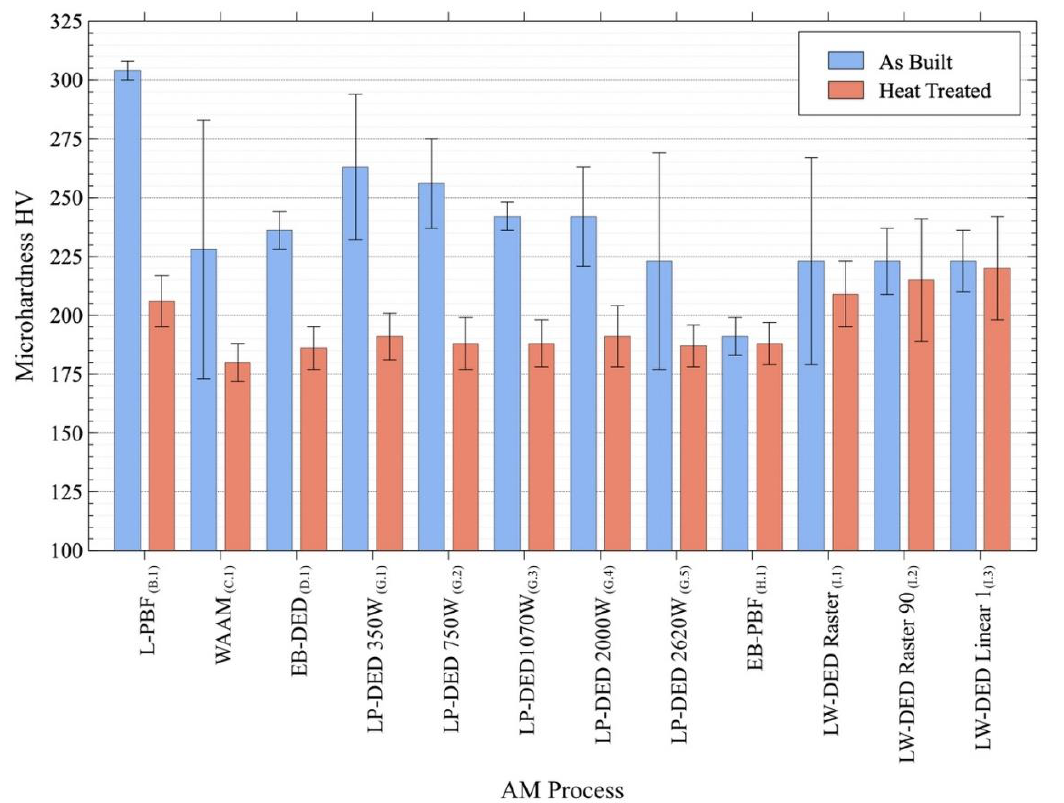
Figure 11. Comparison of microhardness in the as-built versus fully heat-treated (SR + HIP + SOL) condition for AM processes.